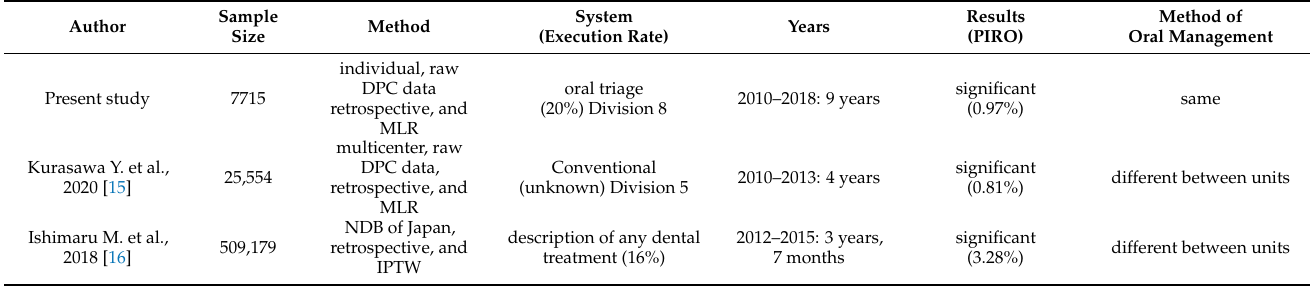
Table 6. Comparison with other similar studies. Pneumonia incidence rate after introducing oral care intervention is abbreviated to PIRO.